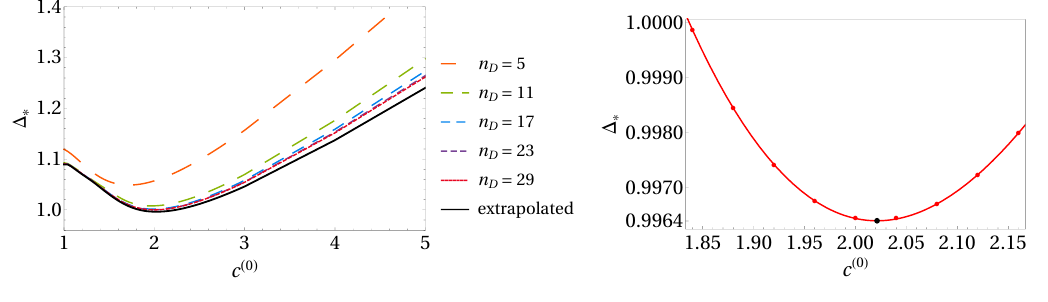
Figure 12 . Left: the upper bound on the gap in the dimension of primaries, (cid:1) (cid:3) , in the trivial representation obtained at increasing derivative order of the linear functional (from blue to red, up to n D = 29). The black curve is the extrapolated value. Right: blown-up plot of the-near minimal (cid:1) (cid:3) region. The minimal is expected at 2 : 00 (cid:20) c (cid:20) 2 : 04, (cid:1) (cid:3) (cid:25) 0 : 995. in SU(2) k = 1, weight (cid:21) (or (cid:22) (cid:21) ) takes values (0) or ( 1 ). The resulting bound on the neutral 2 sector gap is shown as a function of c in (cid:12)gure 12. 11 Notably, there is a minimum of about (cid:1) = 1 near c (cid:17) c (0) + 1 = 3. We next turn to a more detailed study of this (cid:3)